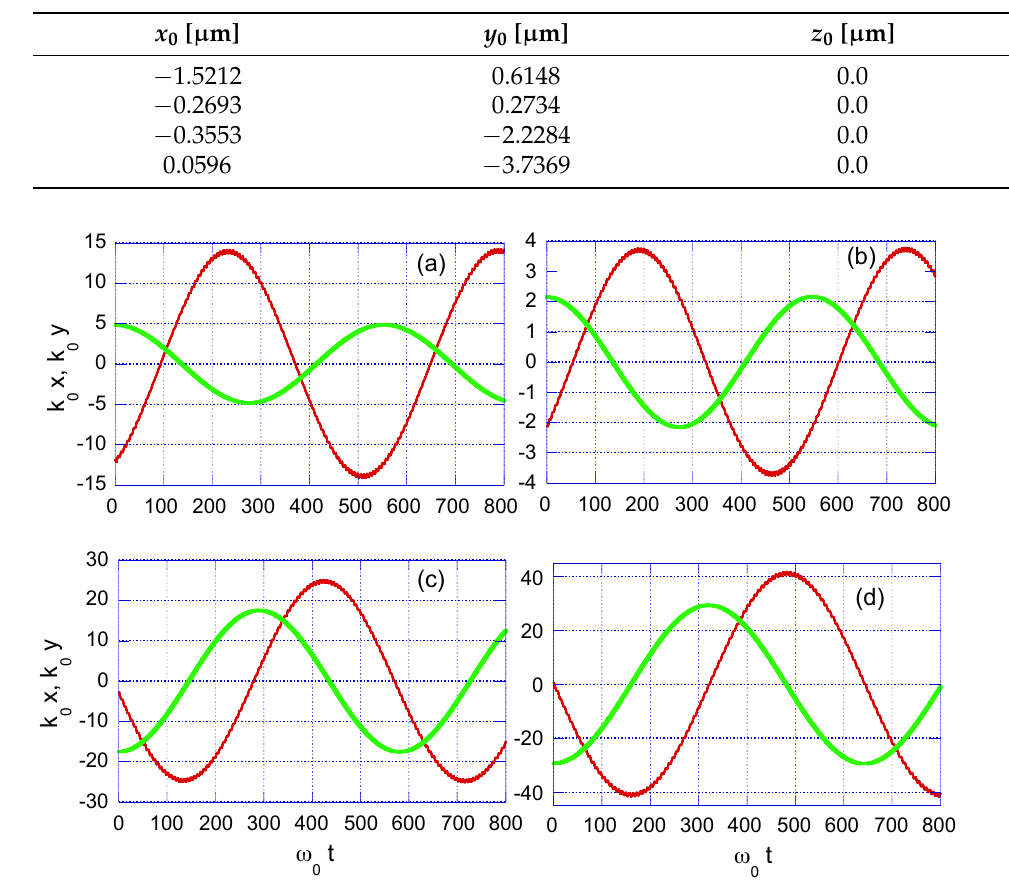
Table 1. Sample initial conditions for trapped trajectories, case-study with w 0 = 100 µ m.